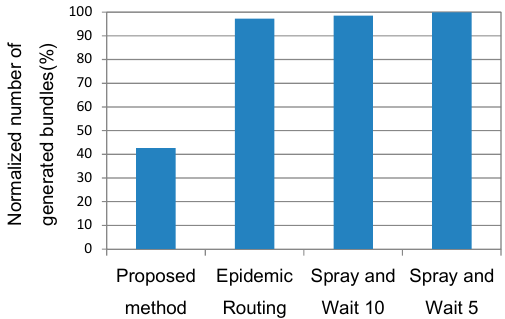
Figure 10. Normalized number of generated bundles where the number of bundles generated